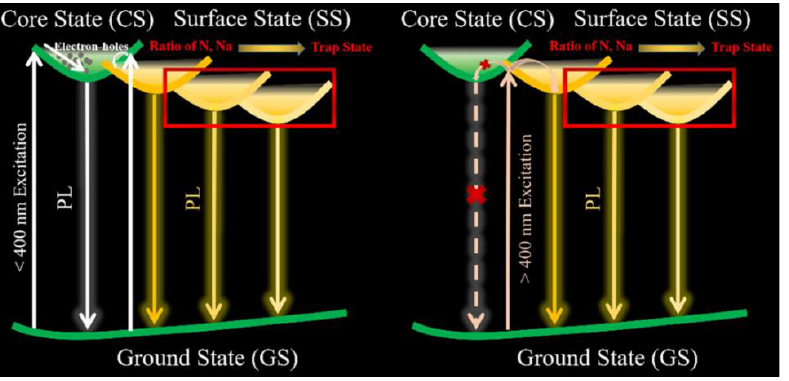
Figure 6. Mechanism representation of the dual fluorescence emission of solid-state N-doped carbon dots. (Reprinted from [47]; with the permission of Elsevier).